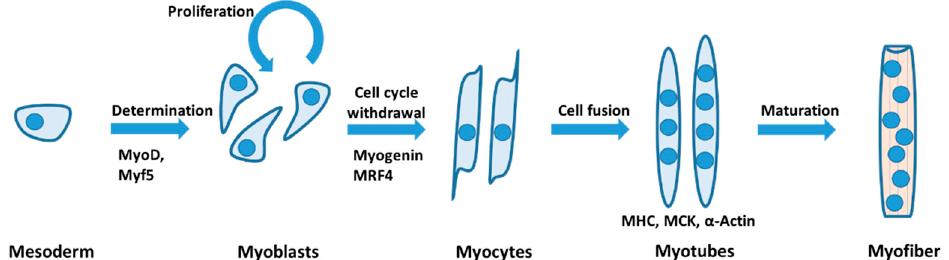
Figure 1. Myogenic differentiation. The scheme shows the differentiation of skeletal muscle from the mesoderm that is determined in the skeletal muscle lineage after MyoD and Myf5 expression. Myoblasts proliferate until they withdraw from the cell cycle and differentiate into myocytes, which involves myogenin and MRF4. Myocytes fuse to form myotubes that express skeletal muscle pro-